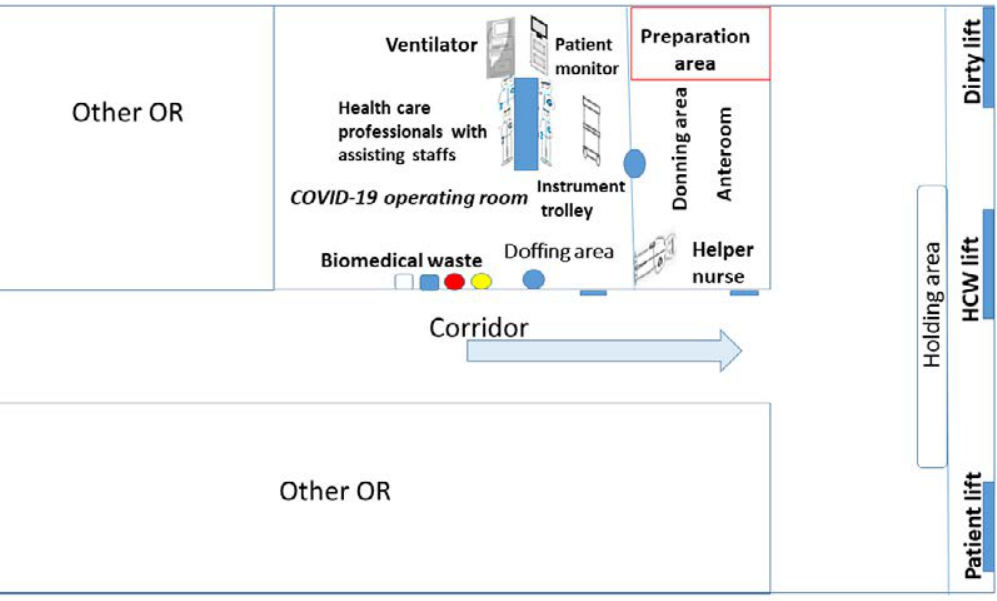
Fig. 1. The hospital operating area with the designated COVID-19 operating room and the